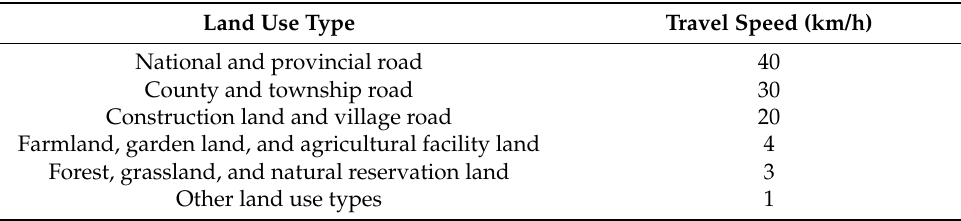
Table 2. Travel speeds for different land use